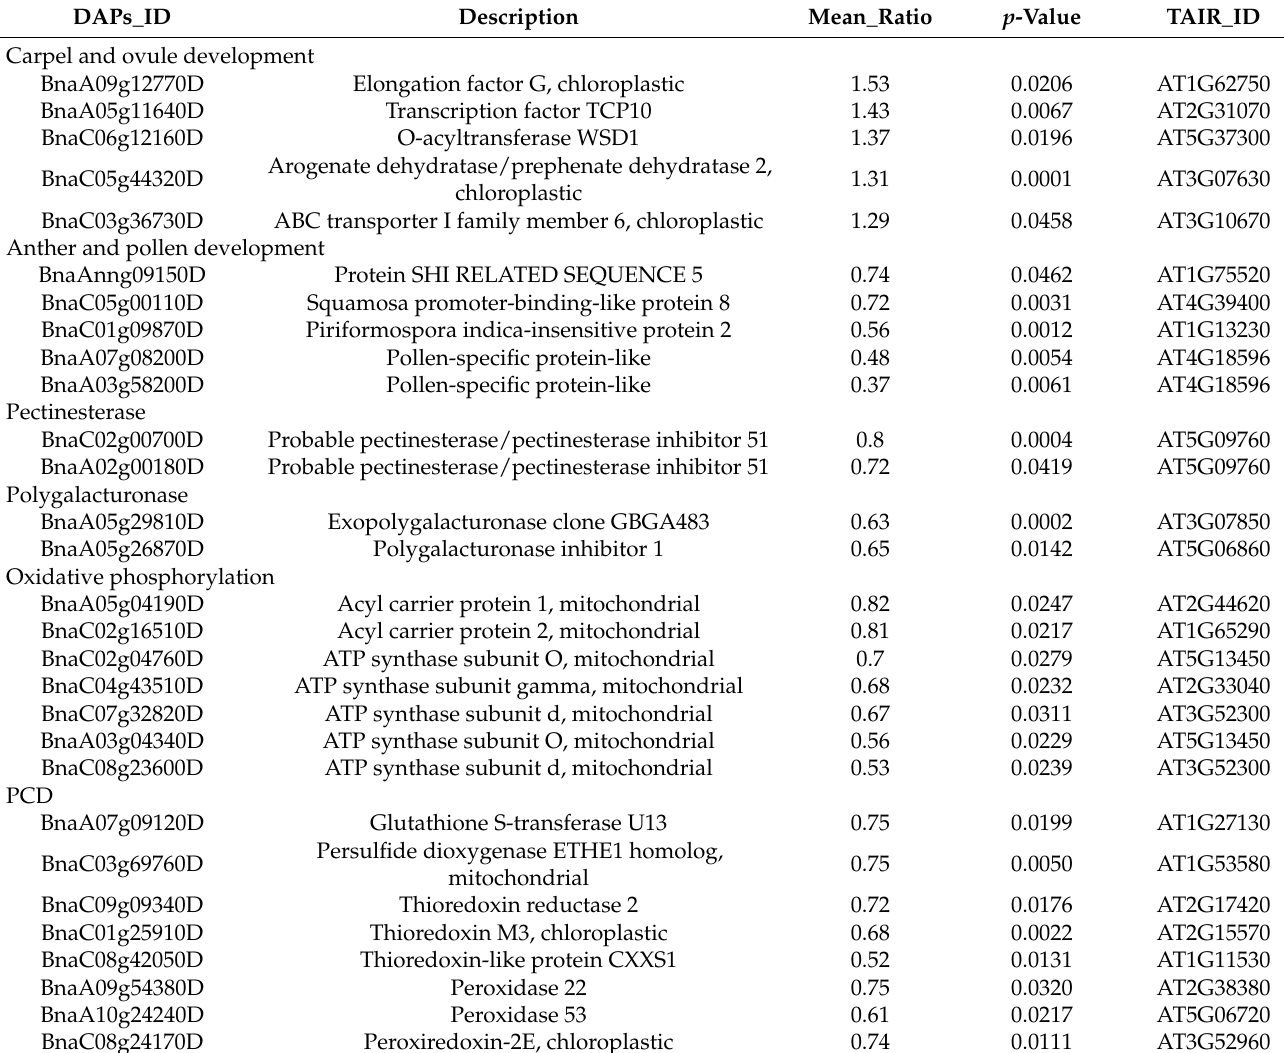
Table 1. The main proteins involved in the occurrence of sterility in inap